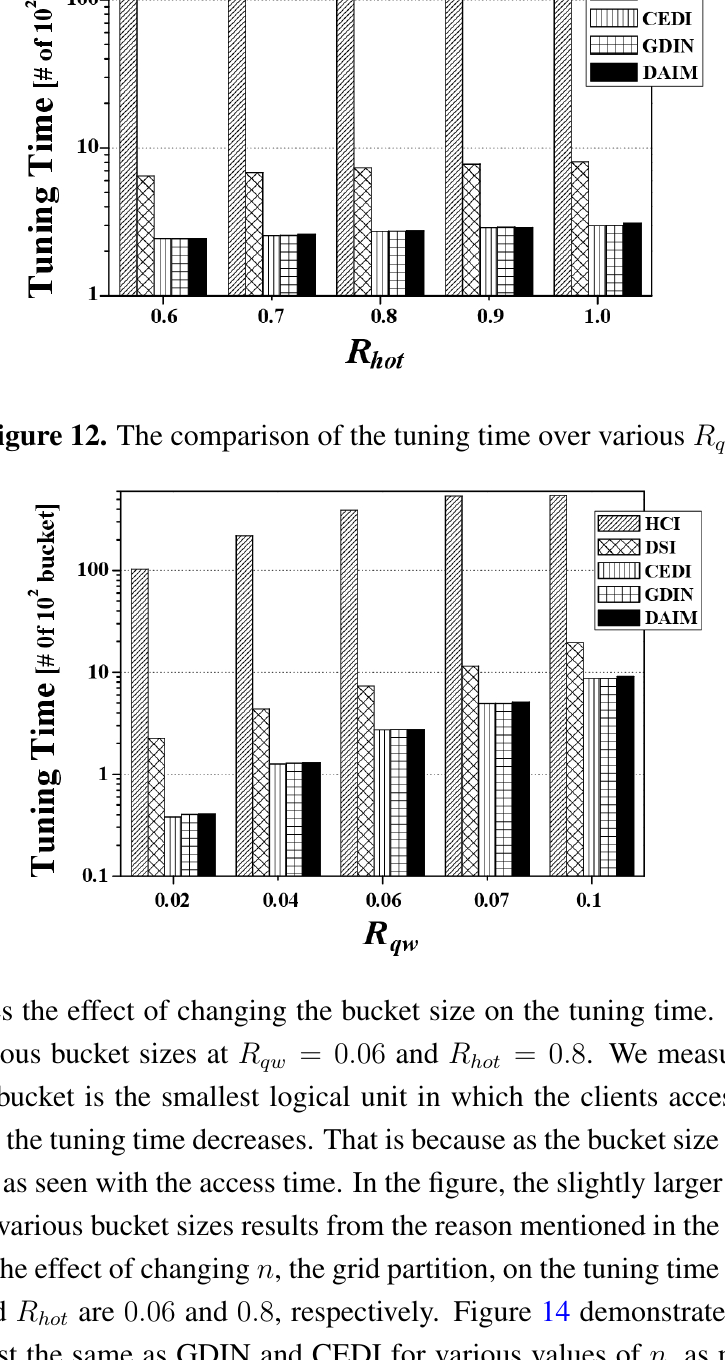
Figure 11. The comparison of the tuning time over various R